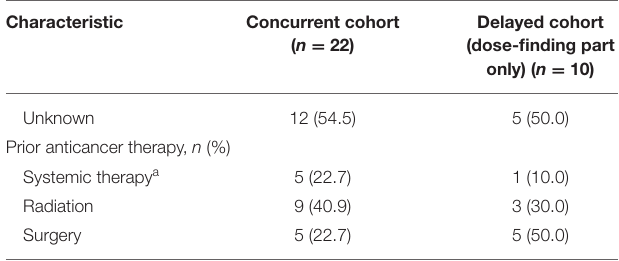
TABLE 1 | Demographic and baseline clinical characteristics.